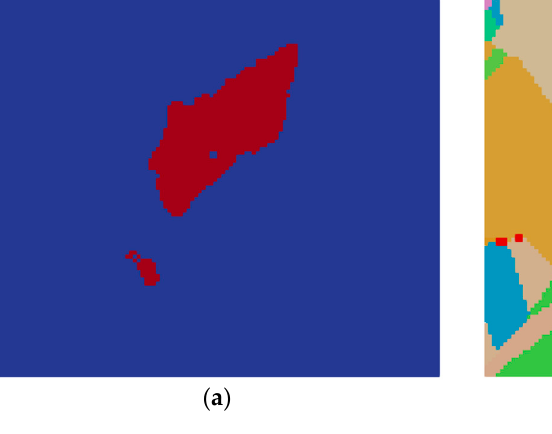
Figure 4. Electron backscatter diffraction (EBSD) map images of the TRIP steel MMC: ( a ) phase map (green—cubic MgO-PSZ greyscale—austenite in band-contrast); and ( b ) Φ 1 plot.